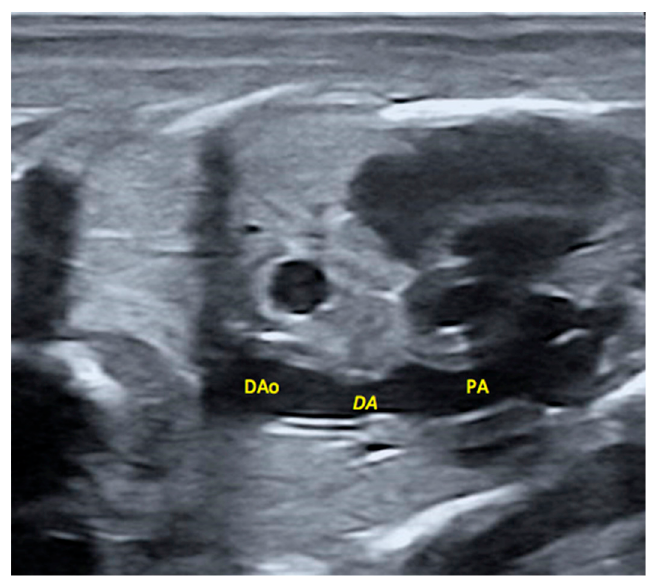
Figure 2. This image shows an apparent narrowing of the ductus arteriosus. DAo: Descending Aorta; DA: Ductus arteriosus; PA: Pulmonary Artery. DA: Ductus arteriosus; PA: Pulmonary Artery.